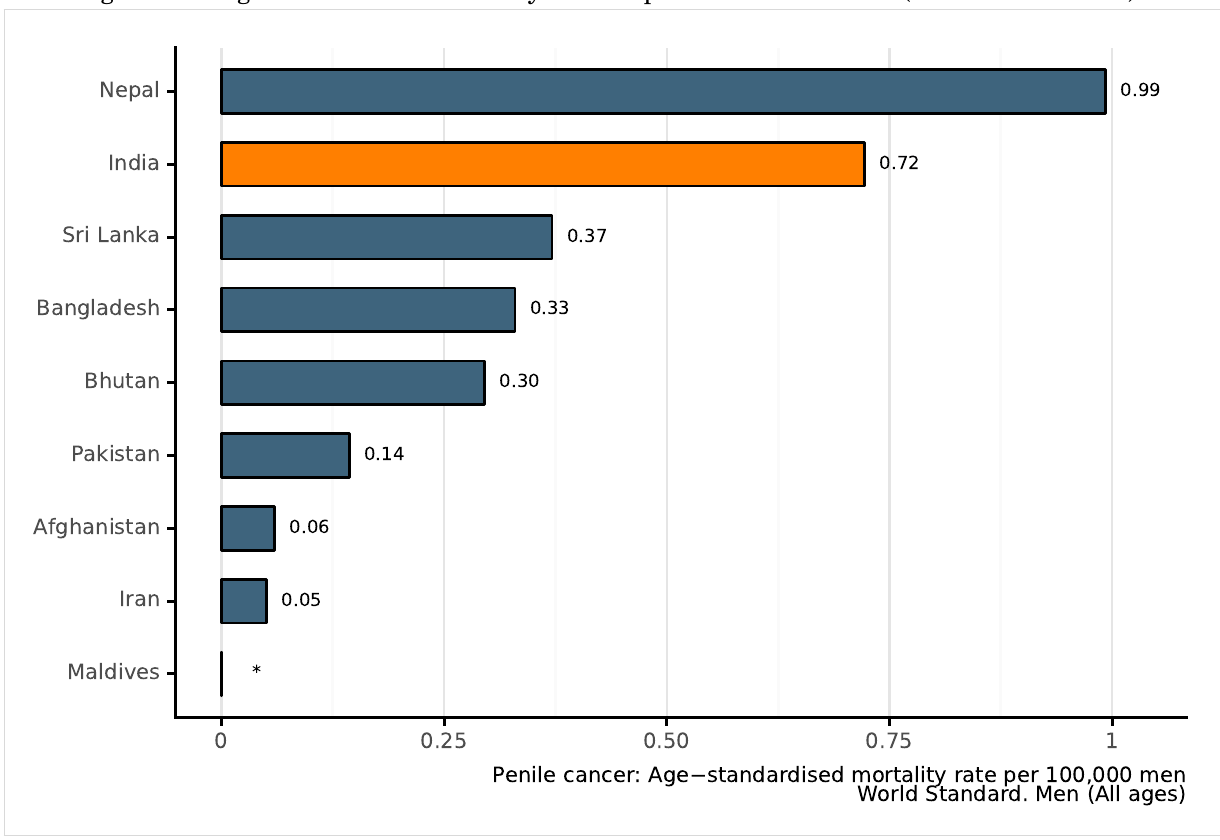
Penile cancer: Age standardised mortality rate per 100,000 men World Standard. Men